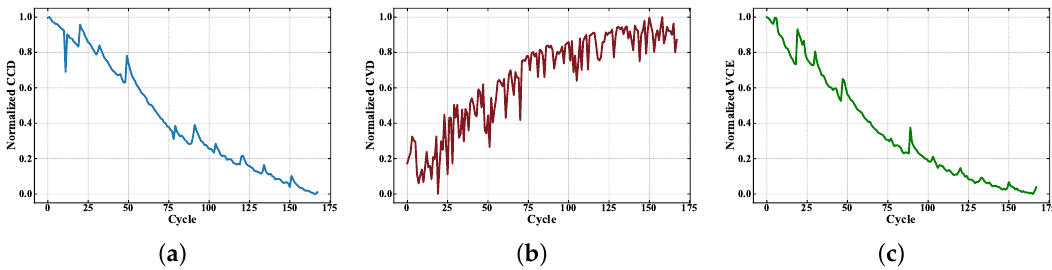
Figure 4. Before the box-cox transformation, changes of features with cycle numbers in Battery #6: ( a ) CCD . ( b ) CVD . ( c ) VCE .